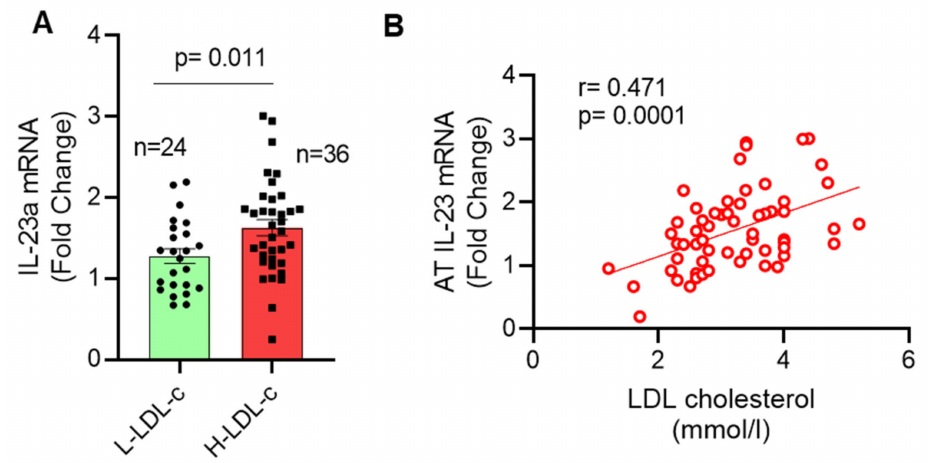
Figure 1. Increased adipose tissue IL-23 gene expression in people with high plasma LDL-c. Adipose tissue samples were obtained from 60 people and divided into two groups based on their plasma LDL-c levels as high LDL-c (<2.9 mmol/L) and low LDL-c group ( ≥ 2.9 mmol/L). Total cellular RNA was isolated from adipose tissue, and IL-23 gene expression was determined by real time qRT-PCR. Relative mRNA expression compared to GAPDH expression was presented as fold change. ( A ) IL-23 levels in each group are shown (bar graph). Each dot represents the individual value of IL-23, and the line represents the mean value. ( B ) Spearman’s correlation between IL-23 gene expression and plasma LDL-c (mmol/L) is shown. Data are represented as mean ± SEM values. Group means were compared using two-tailed unpaired Student’s t -test. A p -value of < 0.05 was considered as statistically